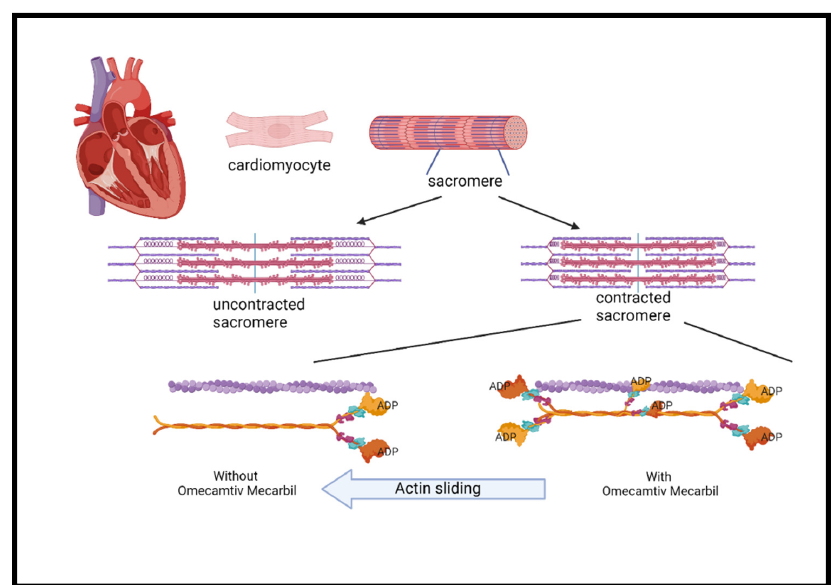
Figure 3. The mechanism of omecamtiv mecarbil. The cardiac myocyte is composed of repeated myofibril units that contain myofilaments. Each unit, termed a sarcomere, is composed of thick and thin filaments, myosin (pink/orange), and actin (purple), respectively. Myosin contains two heads that serve the site of ATPase enzyme that hydrolyzes ATP required for the actin and myosin cross-bridge formation. These heads interact with a binding site on actin and cause the sarcomere length to shorten during contraction. Phosphate is released from ADP to create the force. The more myosin heads containing ADP, the greater the force in each heart contraction. OM binds with highest affinity to myosin heads containing ADP and stabilizes the myosin head in this confirmation 6-fold compared to the other confirmation states. A greater force is produced during each cycle of cardiac contraction. The mechanism has the analogy of hands holding on a rope in which the more hands, the greater the force. ADP = adenosine diphosphate; ATP = adenosine triphosphate; OM = omecamtiv mecarbil.